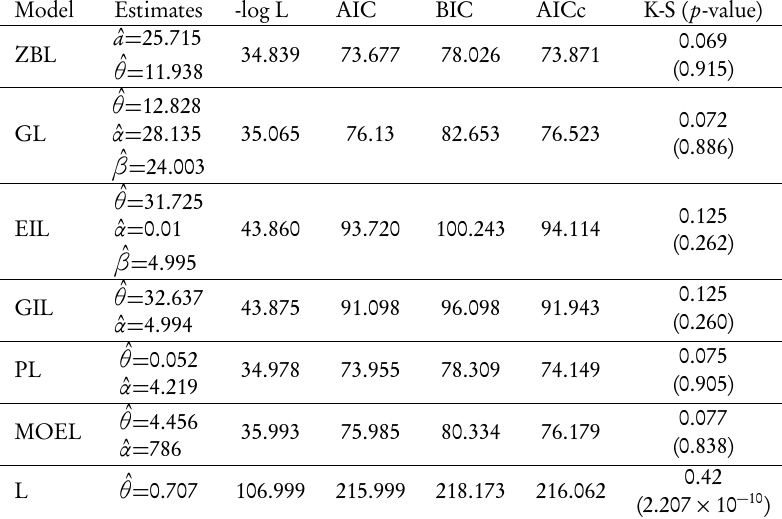
Estimates and statistics for the data of the failure stresses of single carbon